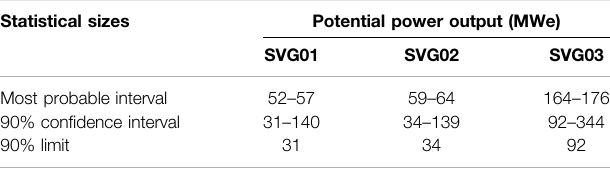
TABLE 4 | The Monte Carlo generation capacity estimates for SVG01, SVG02, and SVG03 for the generation period of 25 – 30 years. Statistical